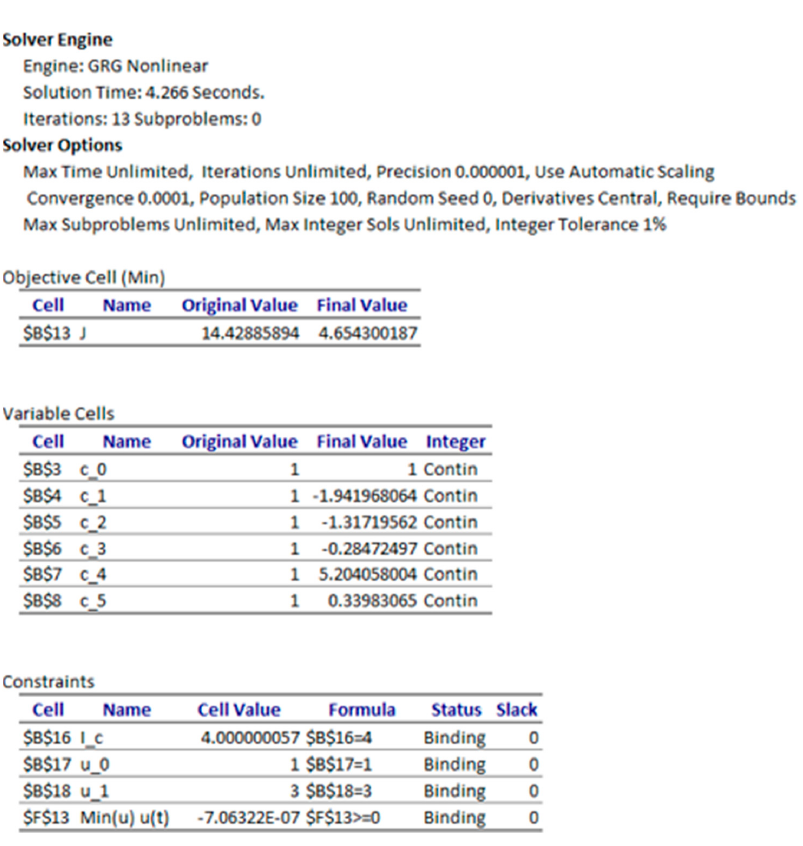
Figure 7. Answer report generated by Excel solver using a 5th order parametrization for problem 3.1 with the added constrained (10).